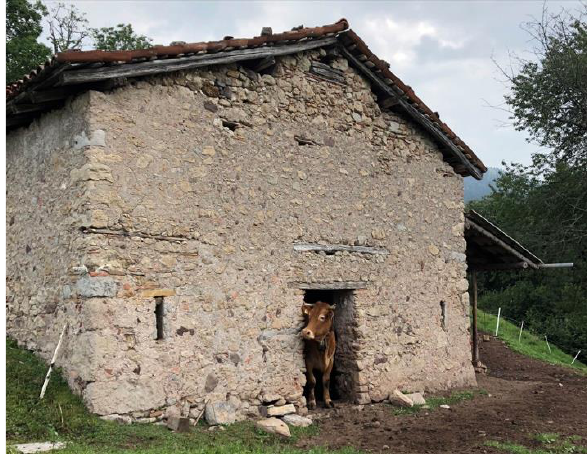
Figure 5. Farmhouse in Bumaghe, Bovegno, Brescia